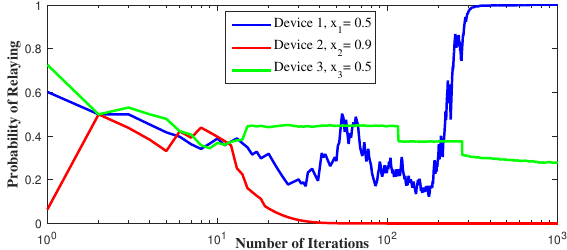
Figure 10. The effect of cooperation level ( x i ) on the convergence to a mixed NE using BG